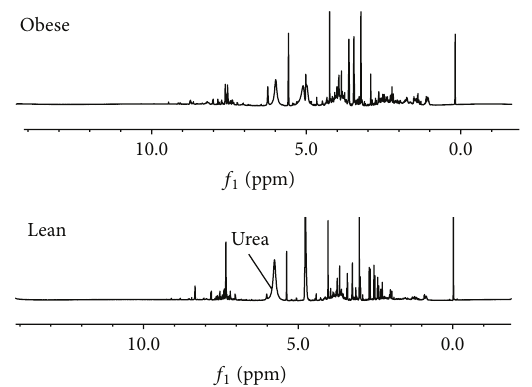
Figure 3: Typical 500 MHz 1 H NMR spectra of urine collected from a Sprague-Dawley rat fed a high fat diet (obese) and a Sprague- Dawley rat fed a normal diet (lean).